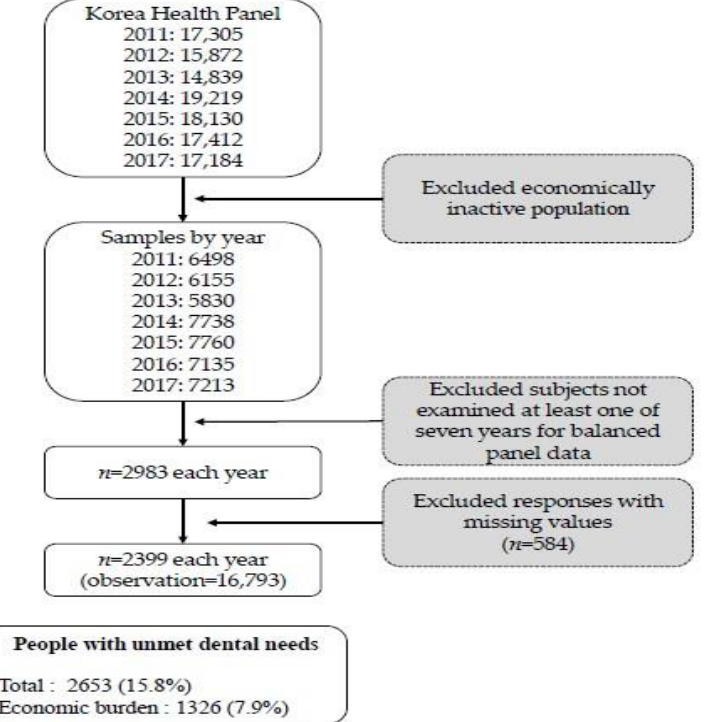
Figure 1. The flow of sample selection in this study.